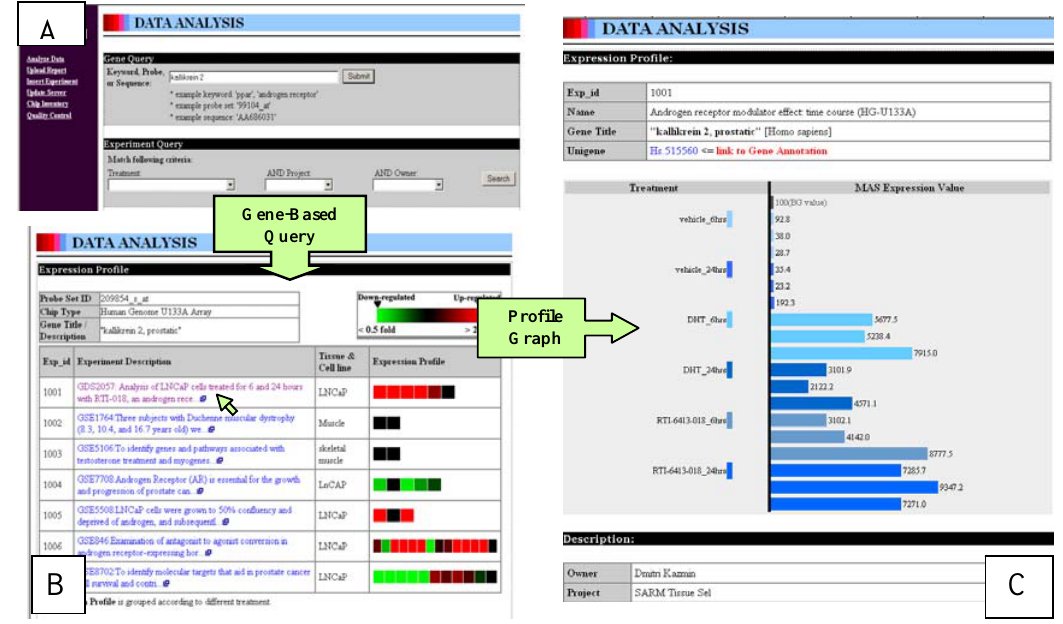
Figure 4: Overview of gene based query in Goober web